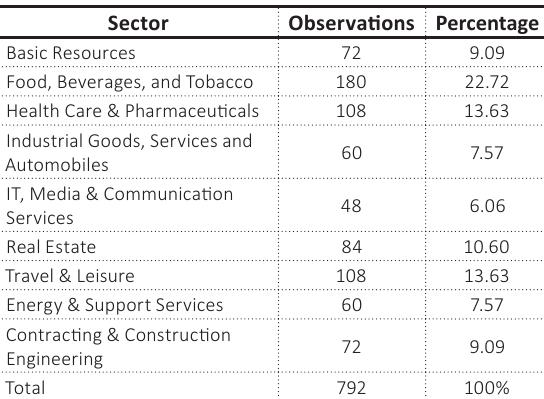
Table 1. Distribution of the sample